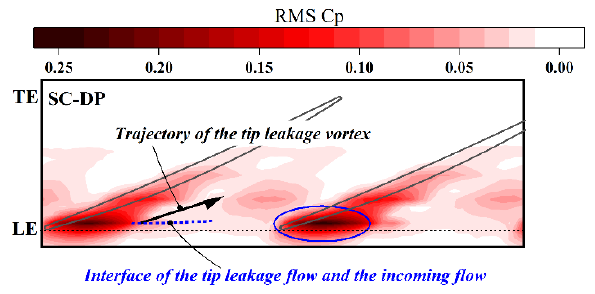
Figure 14. RMS C p contours of the compressor at DP .